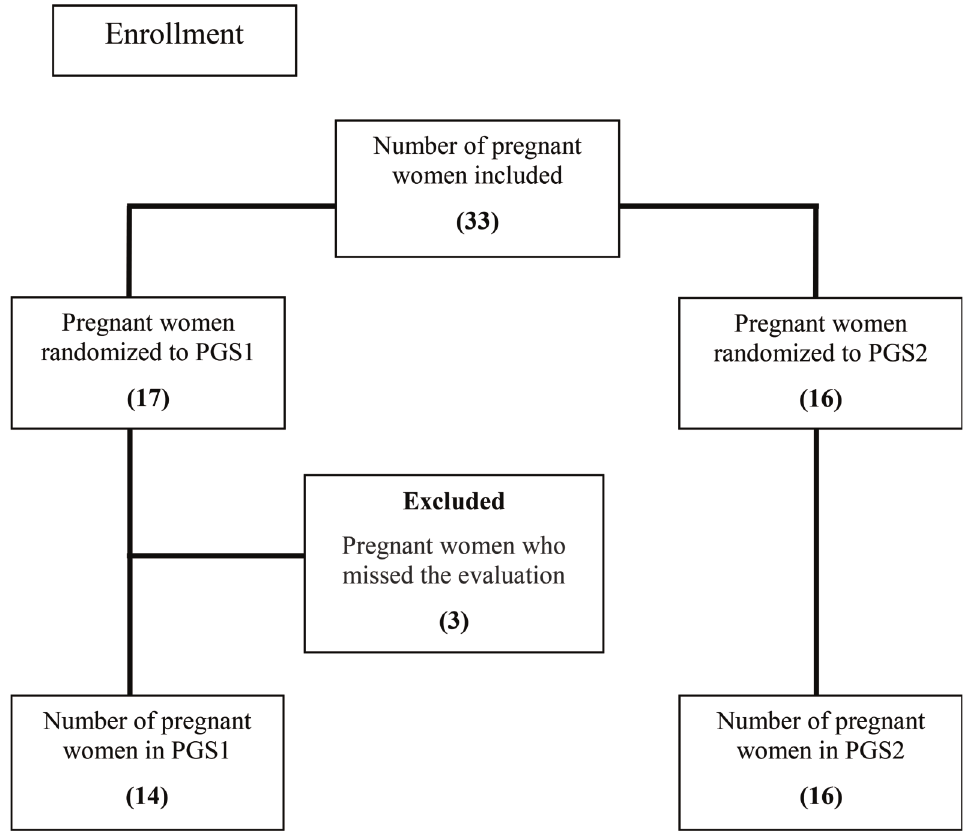
Figure 3 - Flow chart of the total number of participants in pregnant group sequence 1 (PGS1) and pregnant group sequence 2 (PGS2) according to the order of randomization.